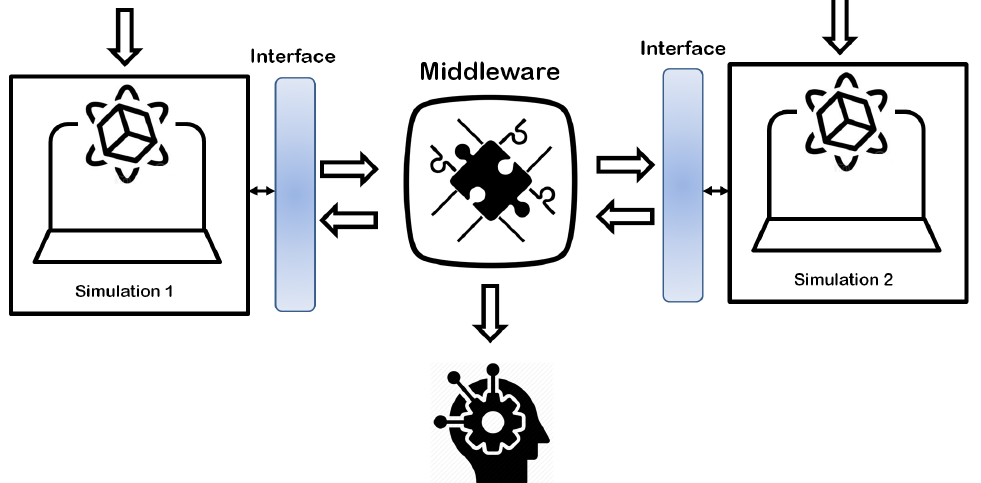
Figure 6. Middleware